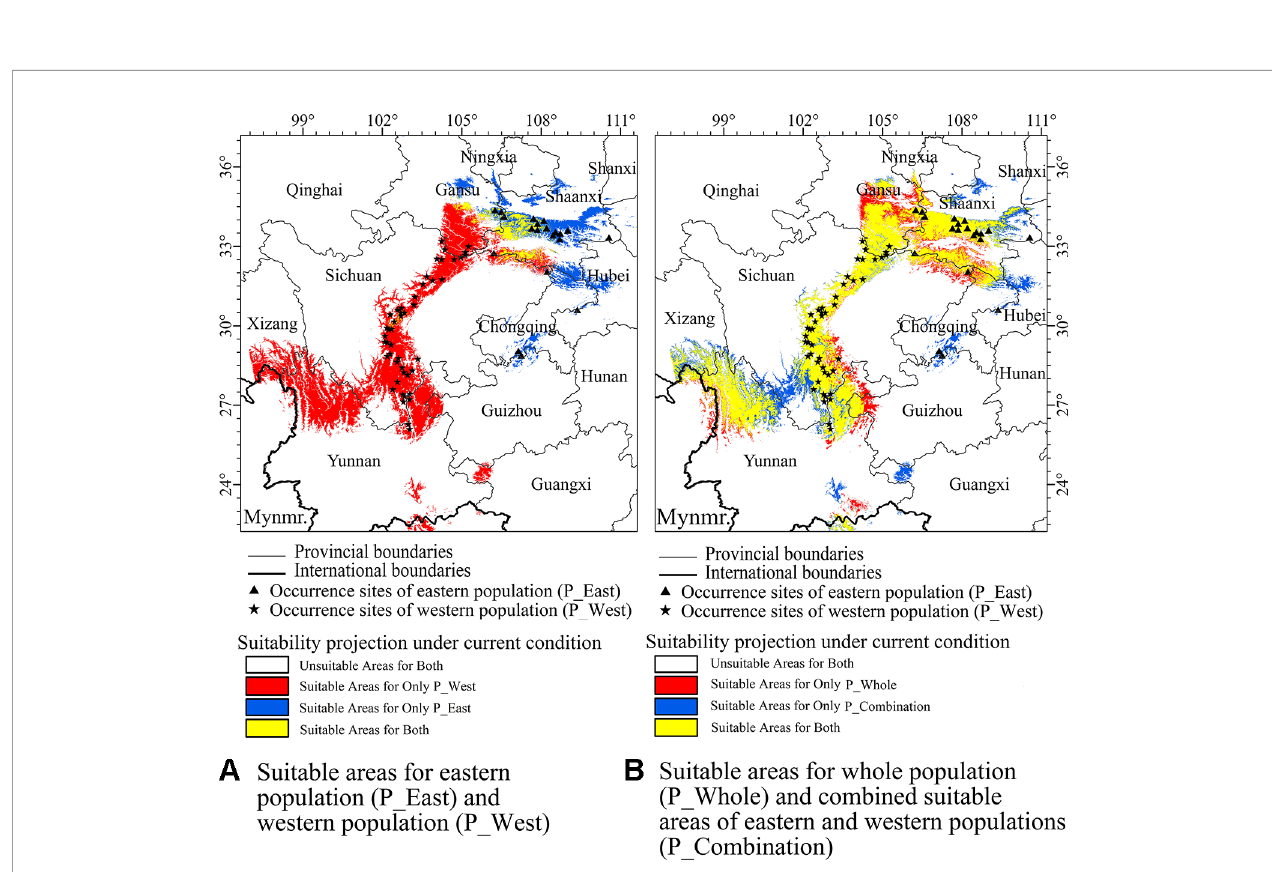
FIGURE 4 | Currently suitable areas which were projected by maximum entropy algorithm (MaxEnt) for western population (P_West), eastern population (P_East), whole population (P_Whole), and an combined result (P_Combination) from suitable areas of P_West and P_East, in which a cell was considered suitable for P. mairei if it was suitable for P_West or P_East. (A) P_West was predicted to occur in middle Sichuan, south Gansu, north Yunnan, and a part of south Shaanxi. P_East was predicted to mainly occur in middle Shaanxi. (B) Compared with the results of P_West and P_East, P_Whole lost a suitable region in south Chongqing, which was reported to be suitable for P.